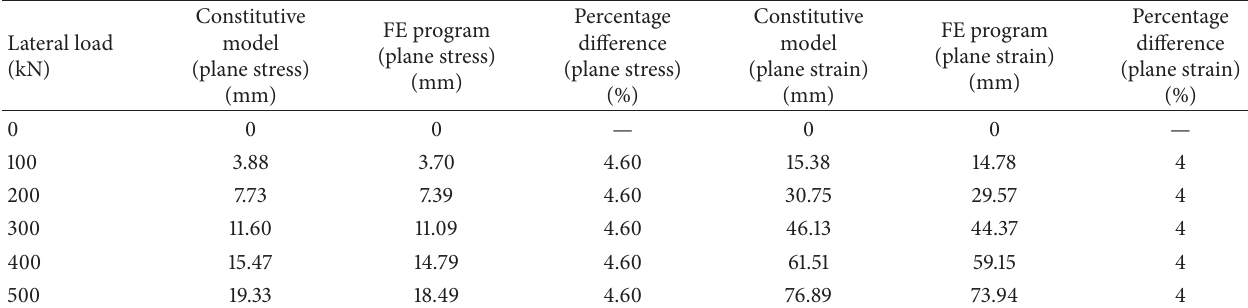
Table 3: Displacement comparison of the constitutive model and FE model of RC1SS at node 1.